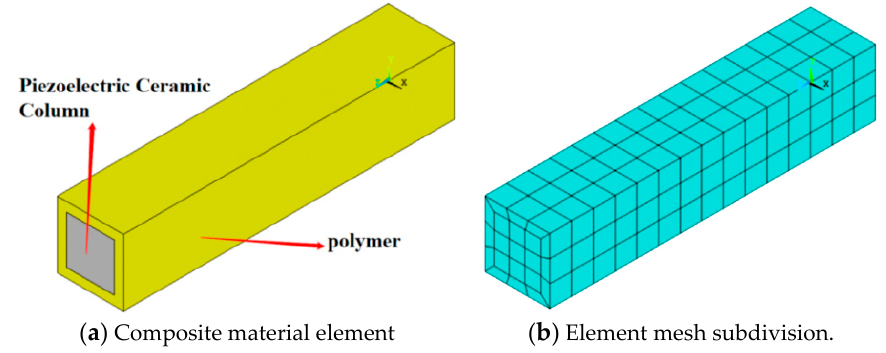
Figure 5. Simulated structural diagram of a 1-3 piezoelectric composite.